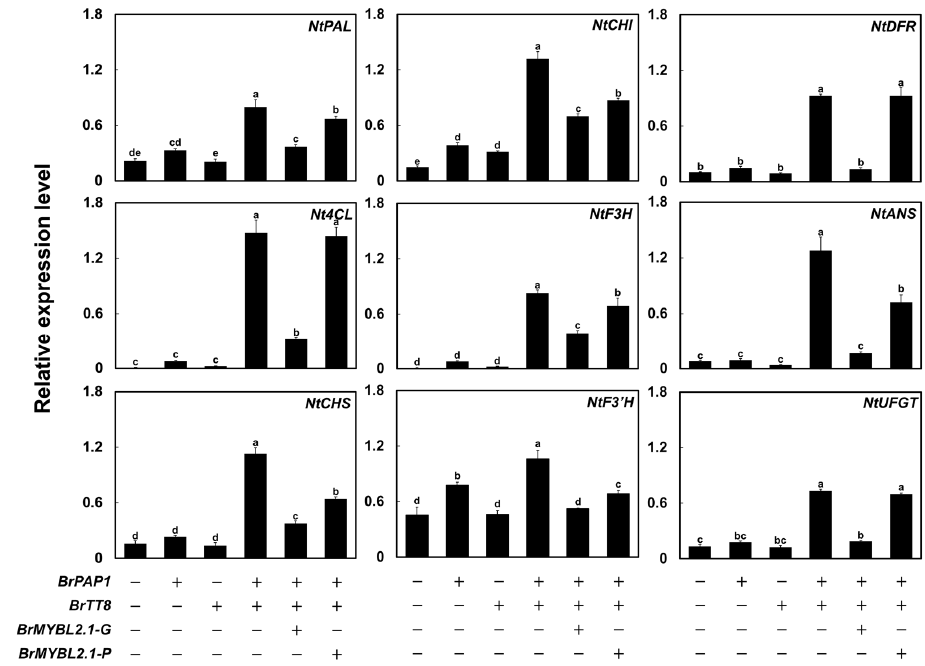
Figure 7. Relative transcript levels of anthocyanin biosynthetic genes in tobacco leaves transiently infiltrated with BrMYBL2.1-G or BrMYBL2.1-P constructs. Relative transcript levels were determined by RT-qPCR, with NtGAPDH used as a reference gene. Results are the means ± SD from three independent biological replicates. Different letters indicate significantly different values ( p < 0.01), as determined by one-way ANOVA followed by Duncan’s multiple range